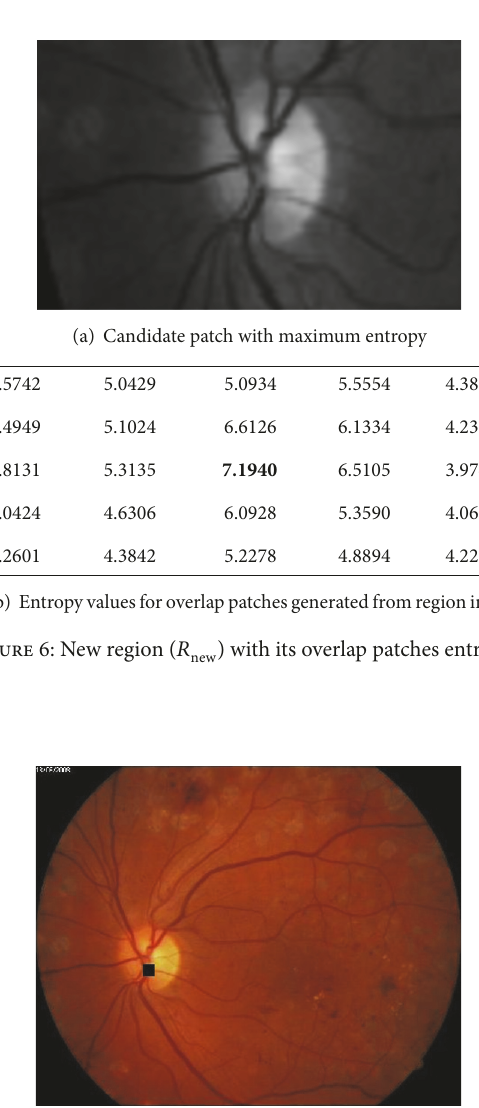
Figure 7: Original image with marking optic disc location.